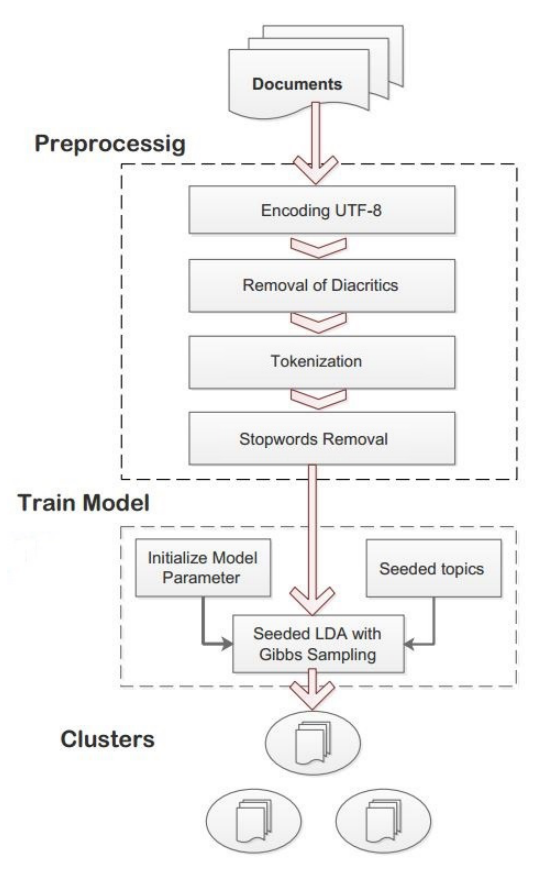
Figure 2. Proposed Seeded-ULDA